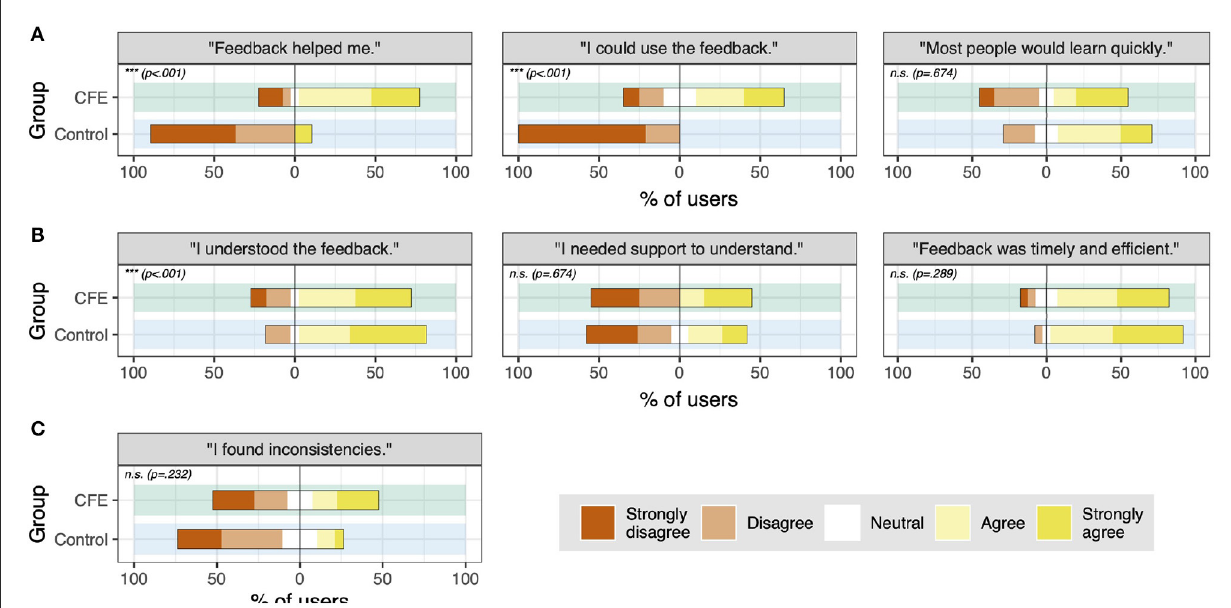
FIGURE6 Experiment 1: Overview of user responses in post-game survey (adapted from Holzinger et al., 2020) per group. (A) Depicts user replies in survey items relevant for hypothesis 2, (B) depicts user replies in survey items relevant for hypothesis 3, and (C) depicts replies relevant for our last exploratory analysis. Statistical information including the respective p -value is given within each item’s box (n.s., not